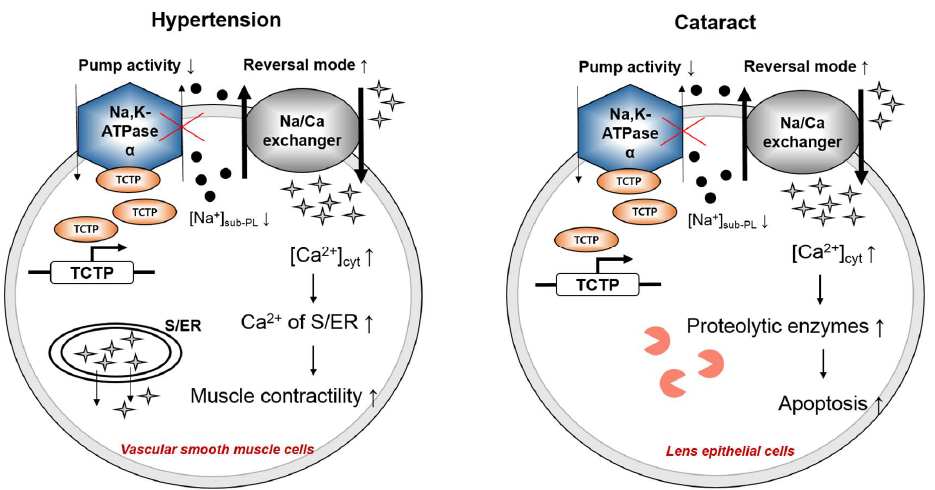
Figure 1. Mechanisms behind hypertension and cataract in TCTP-overexpressing transgenic mice. Systemic arterial hypertension and cataract are induced through the inhibition of Na,K-ATPase, which leads to accumulation of Na + and increase in cytoplasmic Ca 2+ mobilization. Increased Ca 2+ levels in sarcoplasmic reticulum and endoplasmic reticulum(S/ER) cause an increase in vascular smooth muscle contractility, inducing hypertension. In lens epithelial cells, the increased Ca 2+ mobilization activates proteolytic enzymes that cause apoptosis and cataract. ( , Na + ; Ca 2+ ; , proteolytic